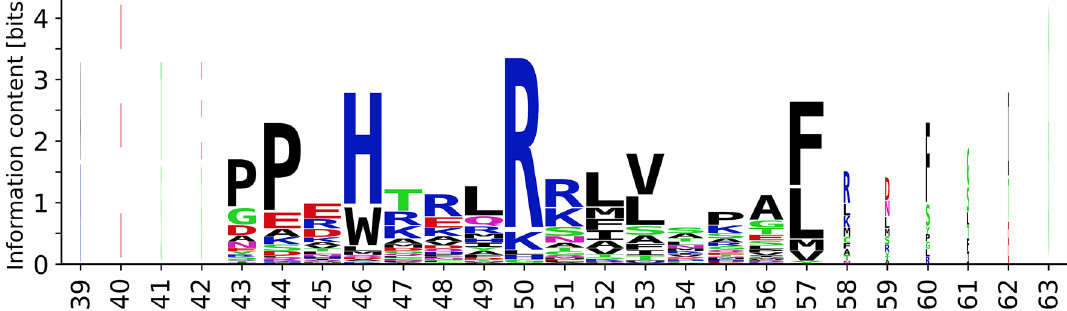
Figure 4. Sequence logo of helix C with generic numbering of residues. The remaining sequence logos are available in Supplementary Figures S3 and